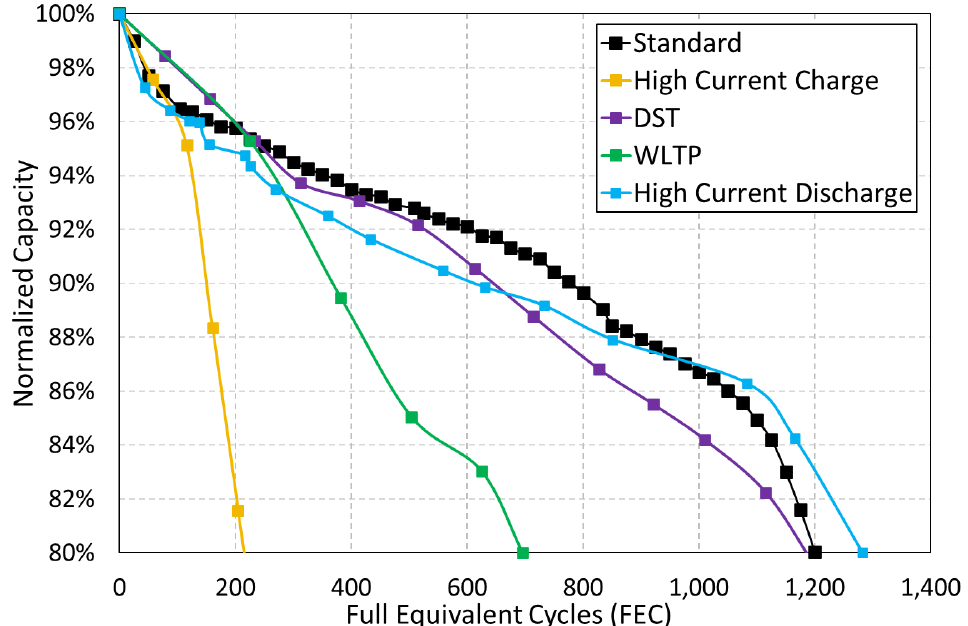
Figure 4. Evolution of normalized cell capacity (under different cycling tests) with the number of full equivalent cycles, calculated as Equation (1).